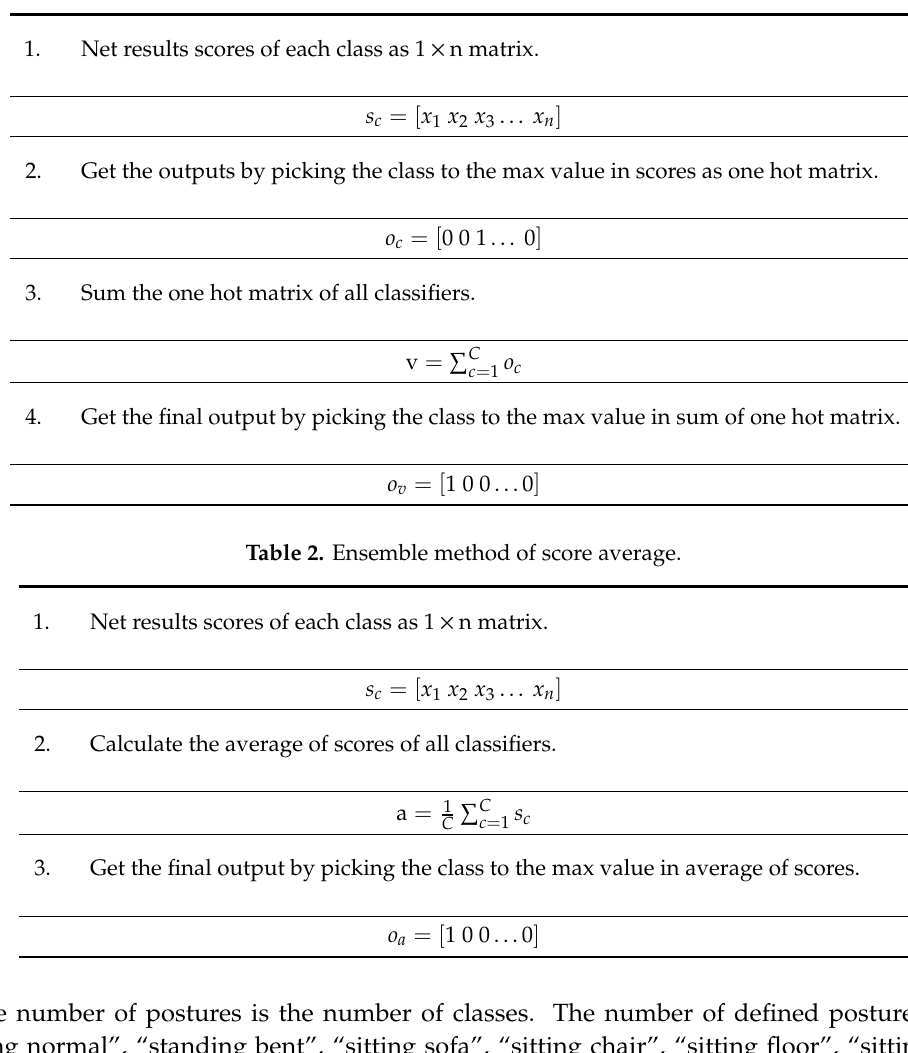
Table 1. Ensemble method of majority vote.